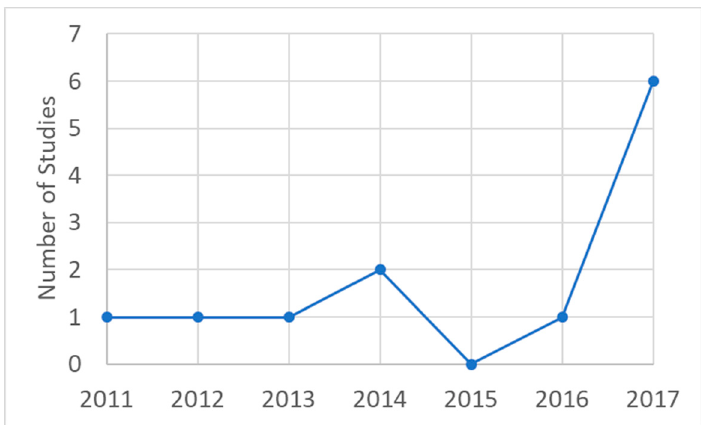
Figure 2. Total number of published ambient air pollution (AAP) epidemiology studies included in the review by year (x ‐ axis). review by year